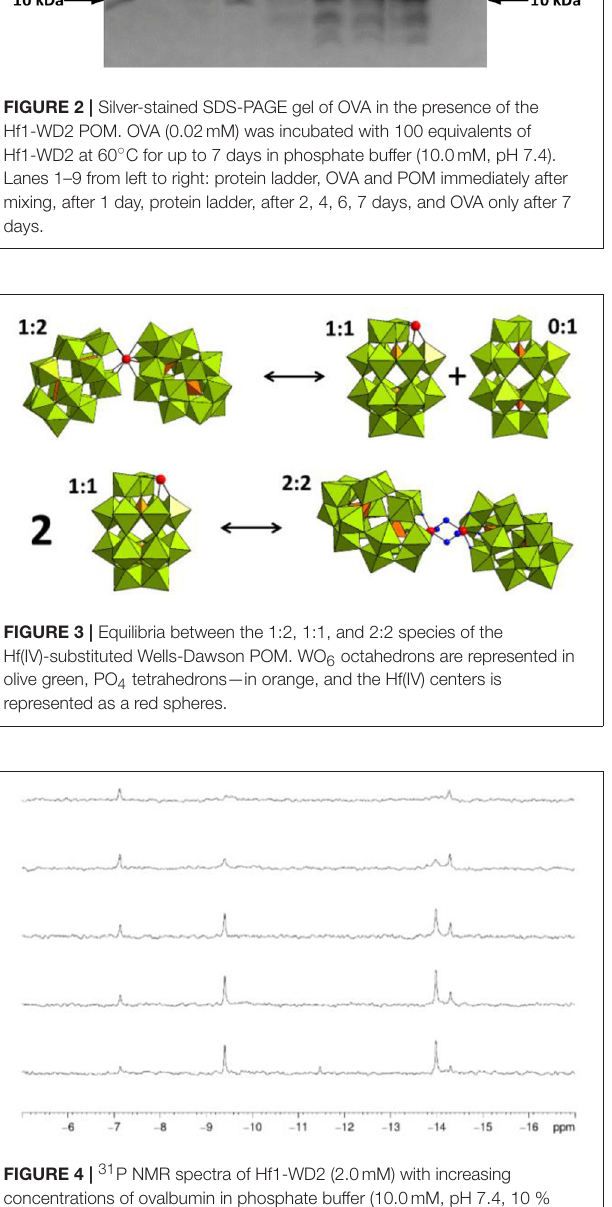
taken place in the presence of Hf1-WD2. To prove that